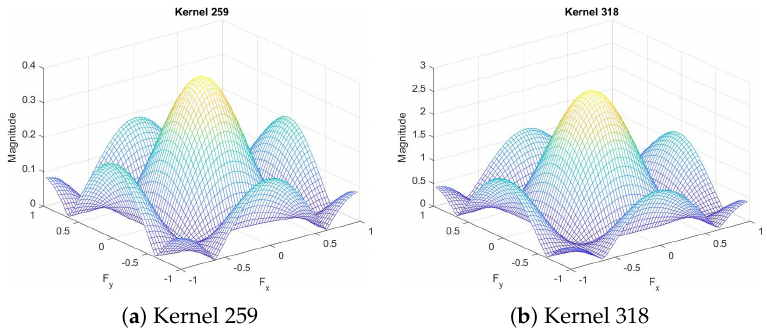
Figure 6. Frequency response of the final convolutional